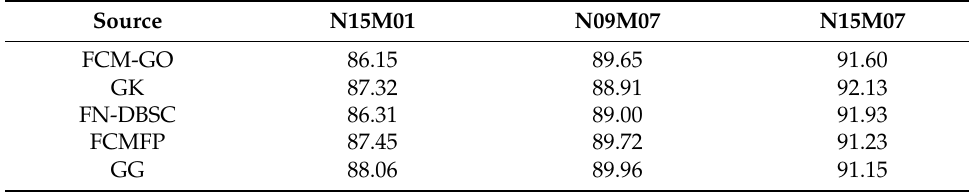
Table 4. Results of earlier damage identification with